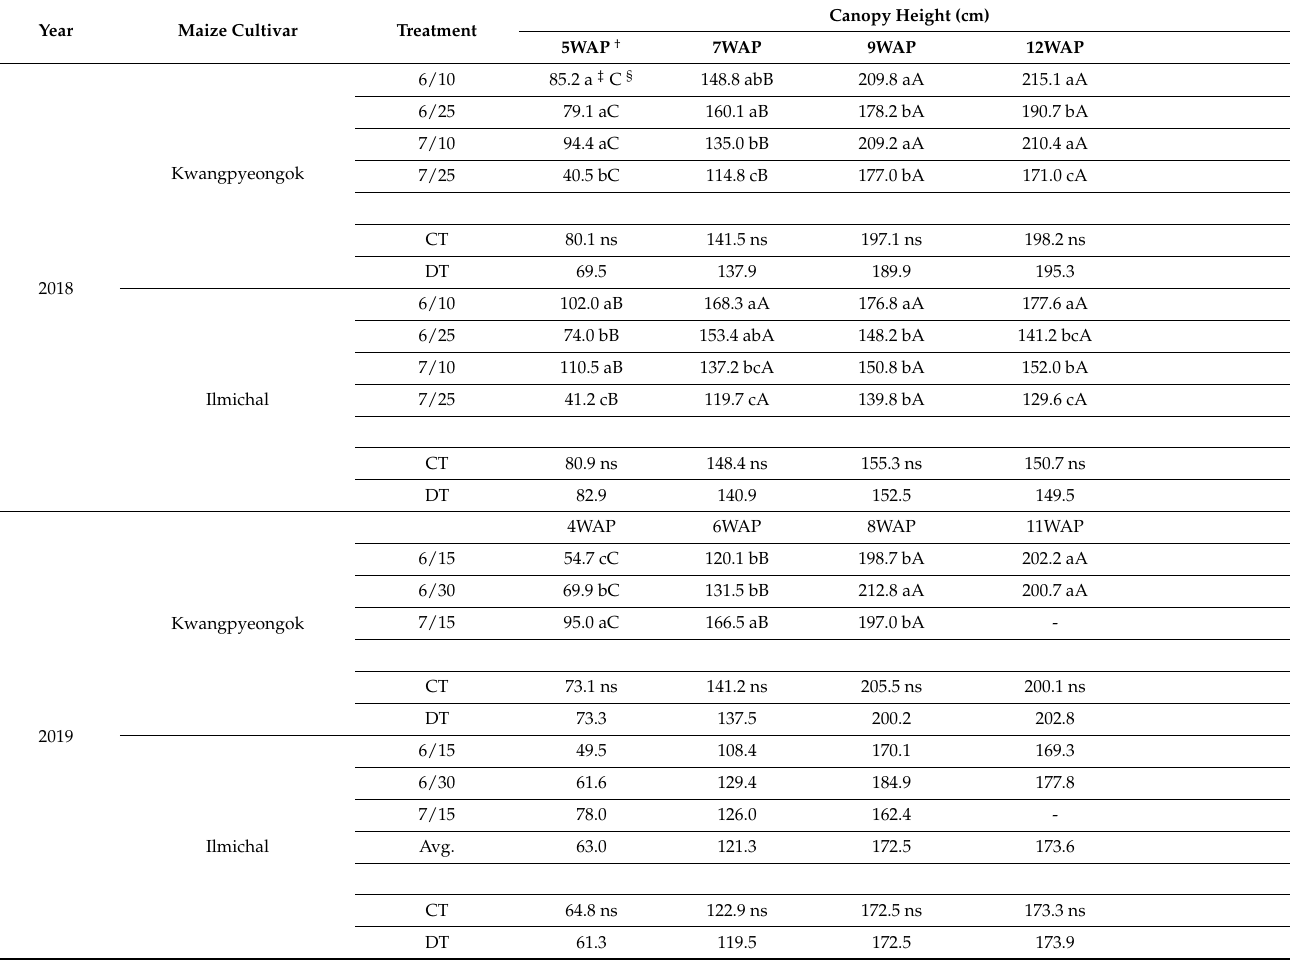
Table 3. Plant canopy height of two maize cultivars (Kwangpyeongok and Ilmichal), as affected by the planting date (6/10, 6/25, 7/10, and 7/25 in 2018; 6/15, 6/30, and 7/15 in 2019–2021) and tillage practice (deep tillage, DT; conventional tillage,